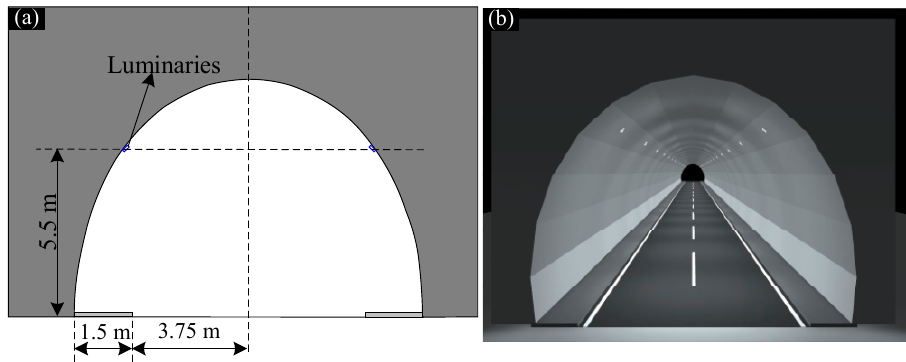
Figure 9. ( a ) cross-section, ( b ) render of the test tunnel by